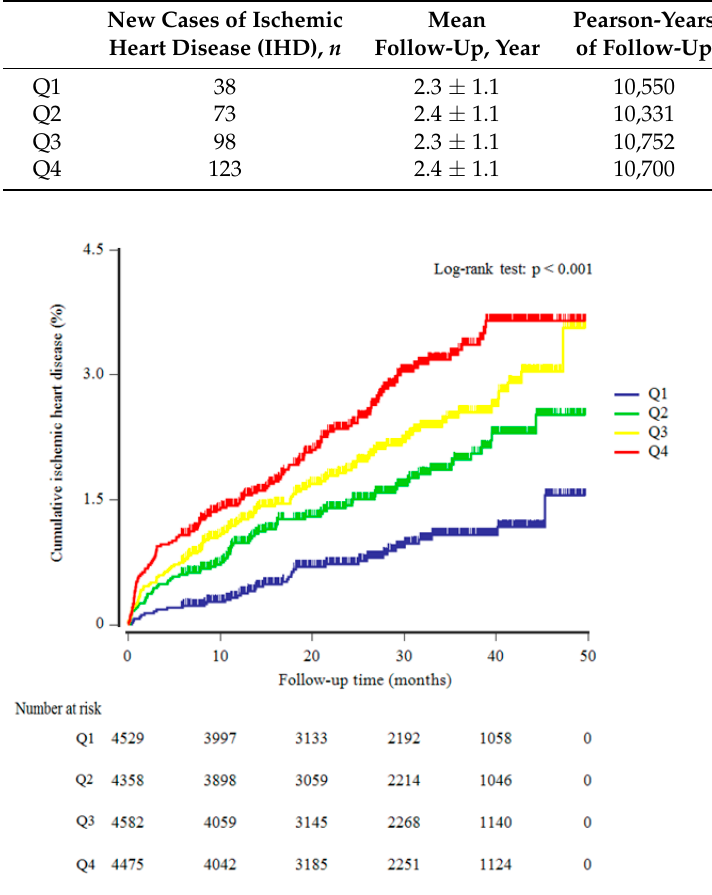
Figure 2. Kaplan–Meier plots indicating the cumulative ischemic heart disease (IHD). Using univariate and multivariate Cox proportional hazards regression analysis, AIP was correlated with new onset IHD in Tables 3 and 4. Compared to the HRs of the first